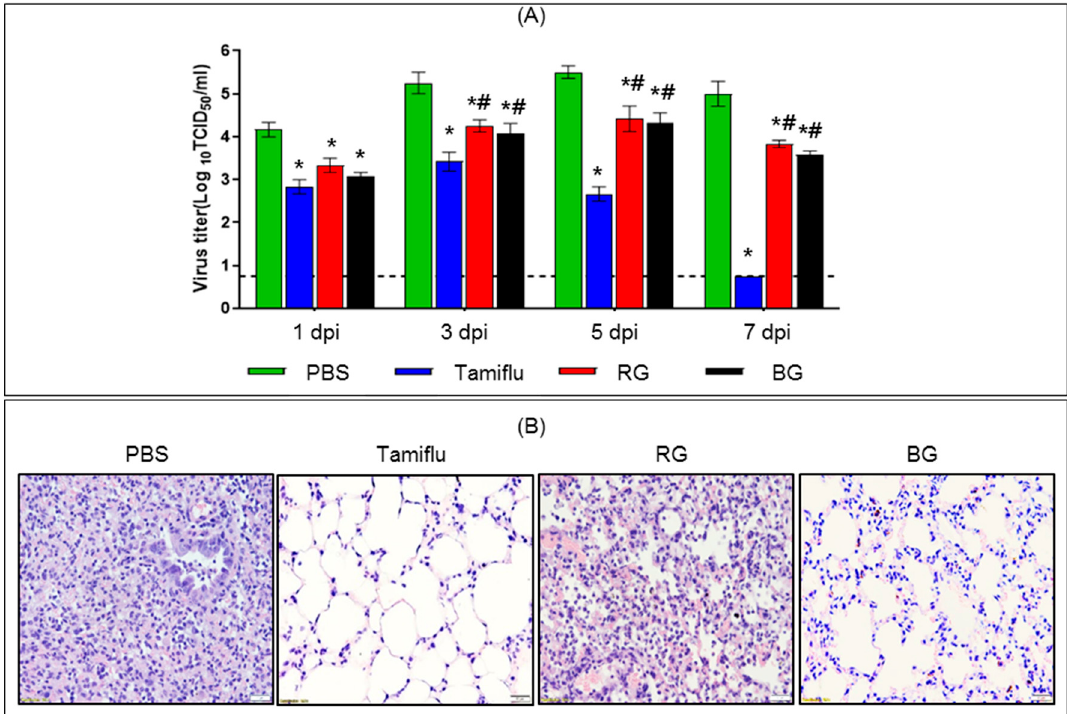
Figure 4. Treatment with BG improves antiviral activity and prevents histopathological alterations following viral infection. ( A ) PBS-, Tamiflu-, RG-, and BG- treated mice were euthanized to collect lung tissues at 1, 3, 5, and 7 dpi. Uninfected mouse lungs were also isolated to use as an intact control (dotted line). Lung viral titer was determined in homogenized tissues by the hemagglutination test. Values are mean (n = 6 per group at each time point) ± SEM. *, p < 0.05 vs. PBS; #, p < 0.05 vs. Tamiflu. ( B ) At 5 dpi, paraffin-embedded lung samples were prepared from infected mice treated with either PBS, Tamiflu, RG, or BG. Representative histological sections of lung tissues stained with H&E to visualize inflammatory lesions (magnification: × 100).